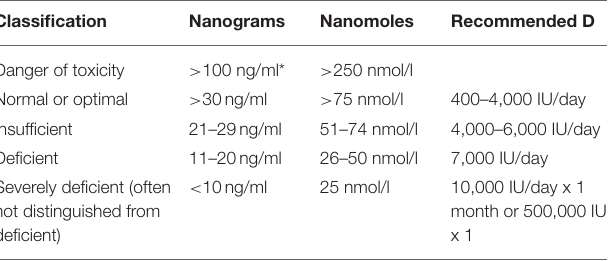
TABLE 1 | Classification of vitamin D levels (serum 25(OH)D levels): (3–5, 12,